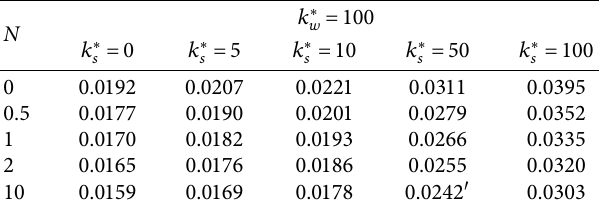
Table 7: First nondimensional natural frequencies ϖ of ZrO SUS304 plates depending on k ∗ w ( T � 500 K).